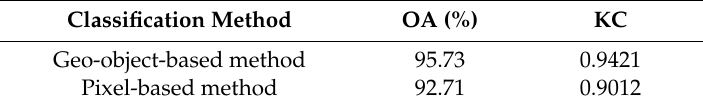
Table 6. Comparison of the accuracy achieved using the proposed geo-object-based method with the pixel-based method.